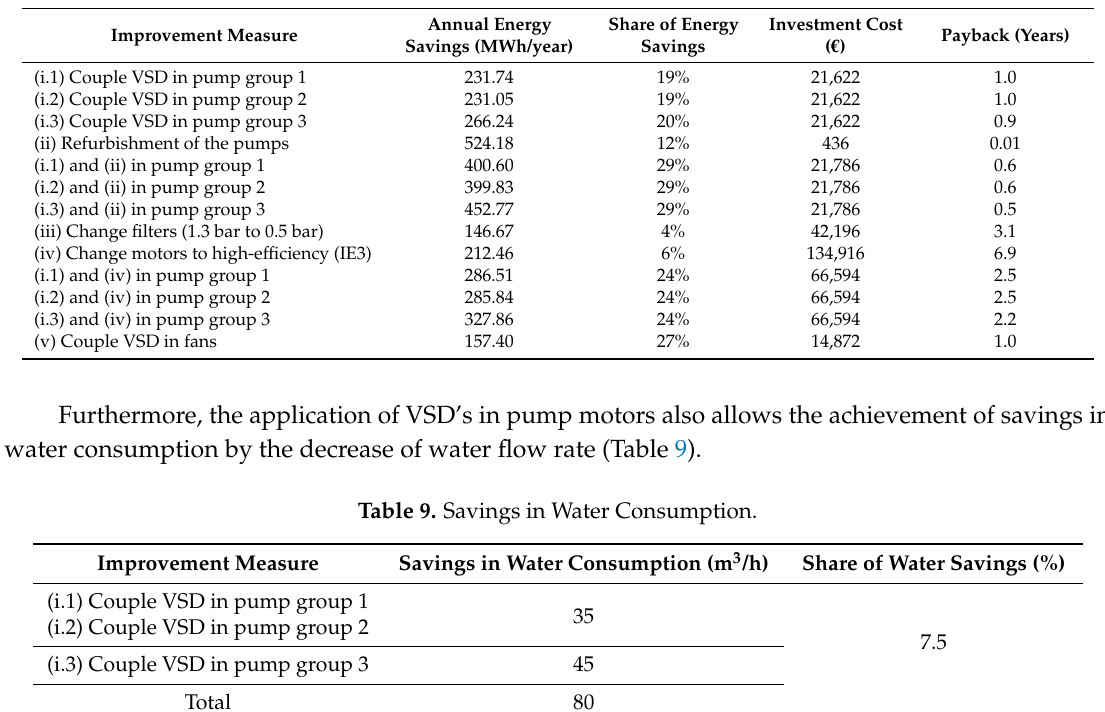
Table 8. Energy savings, investment cost and payback period of proposed measures.